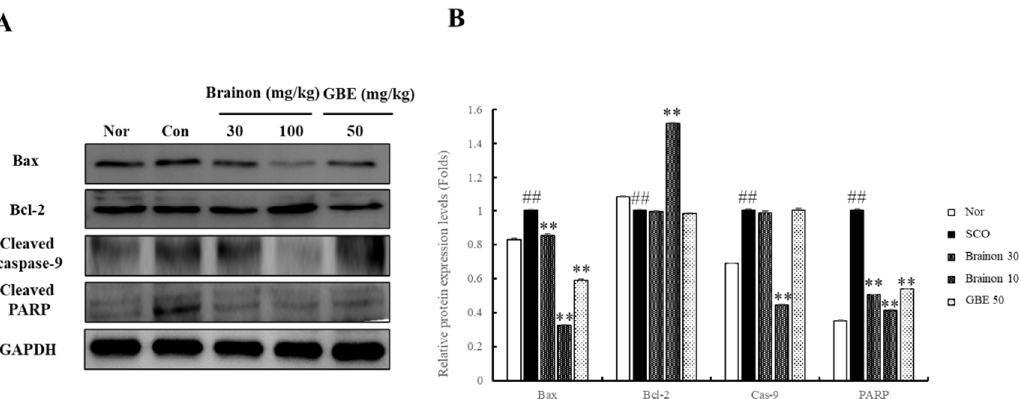
Figure 8. Effects of Brainon on cell death-related protein expression in the memory deficit mice hippocampal tissues. ( A ) Bcl-2-associated X protein (Bax), B-cell lymphoma 2 (Bcl-2), cleaved caspase-9 and cleaved poly (adenosine diphosphate (ADP)-ribose) polymerase (PARP) protein was analyzed using western blotting. ( B ) The density of the protein bands was determined utilizing the software. Protein was normalized using the GAPDH. Values are represented as means ± SEM ( n = 3). ## p < 0.01 vs. Normal group; ** p < 0.01 vs. SCO-treated group.